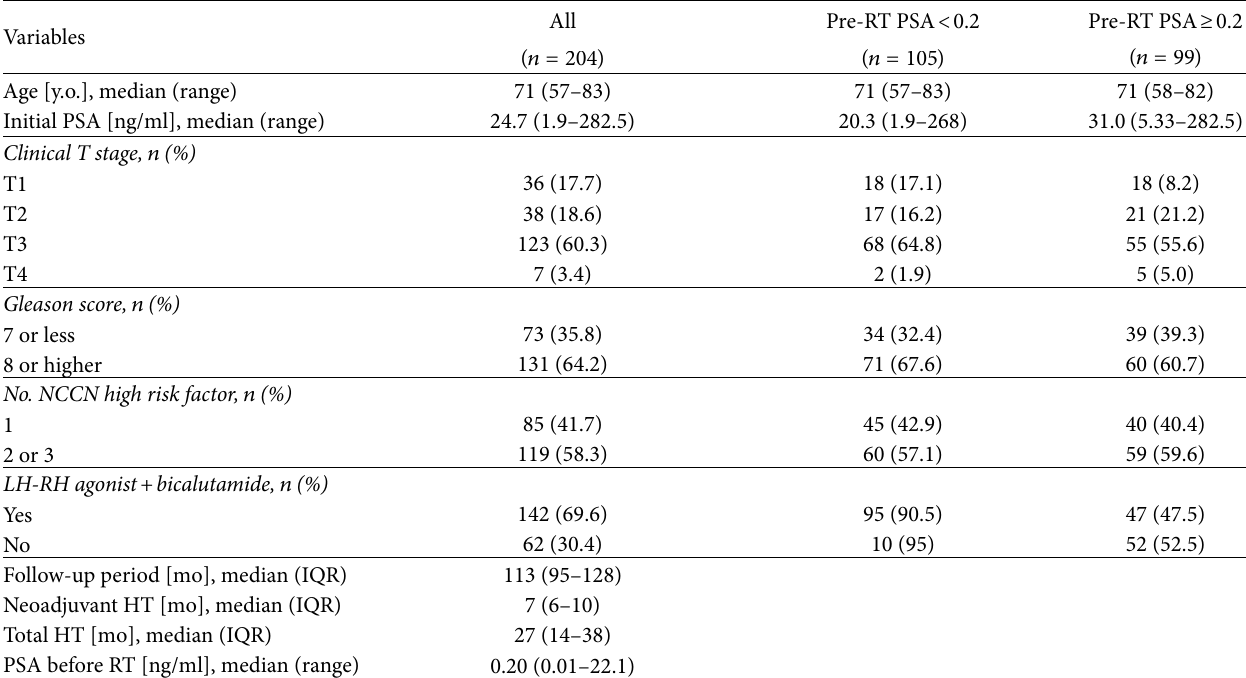
Table 1: Patient and treatment characteristics, compared between patients with a pre-RT PSA <0.2 ng/ml and ≥0.2 ng/ml. All Pre-RT PSA < Variables